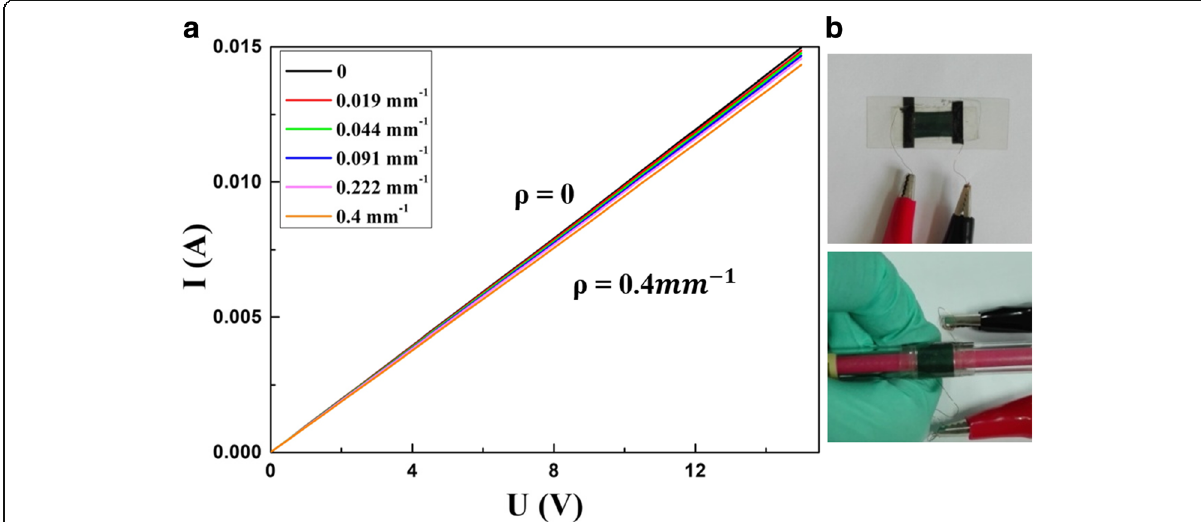
Fig. 7 a I - V curves of the PANI/TPU membrane sensor under different curvatures. b Optical images during the test of I - V characteristics under different curvatures